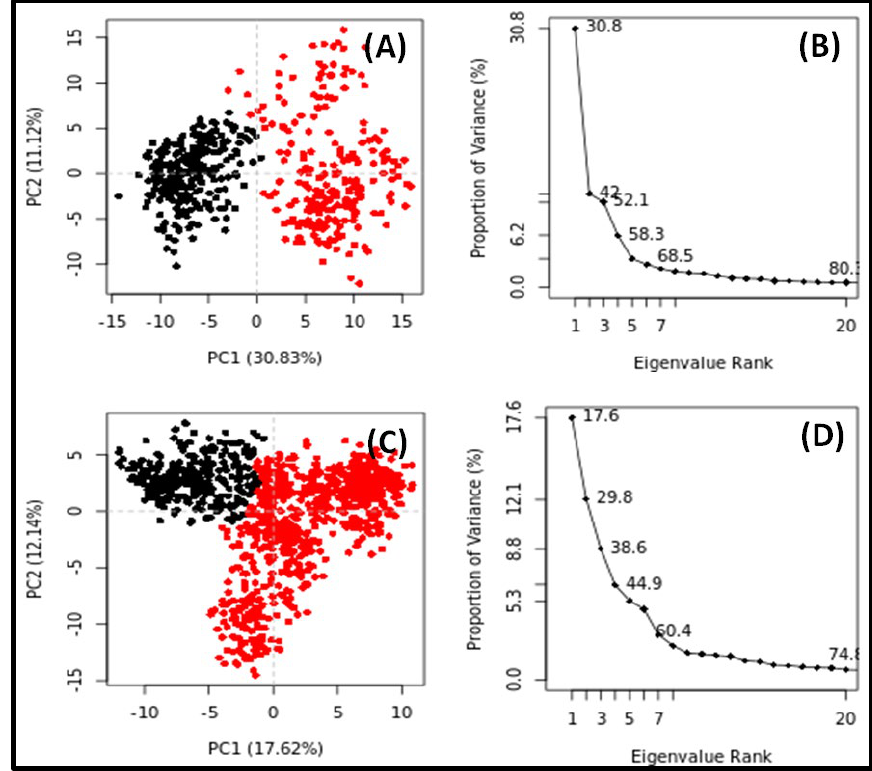
Figure 5 . Principal component analysis (PCA) of NDM-1 in the absence and presence of